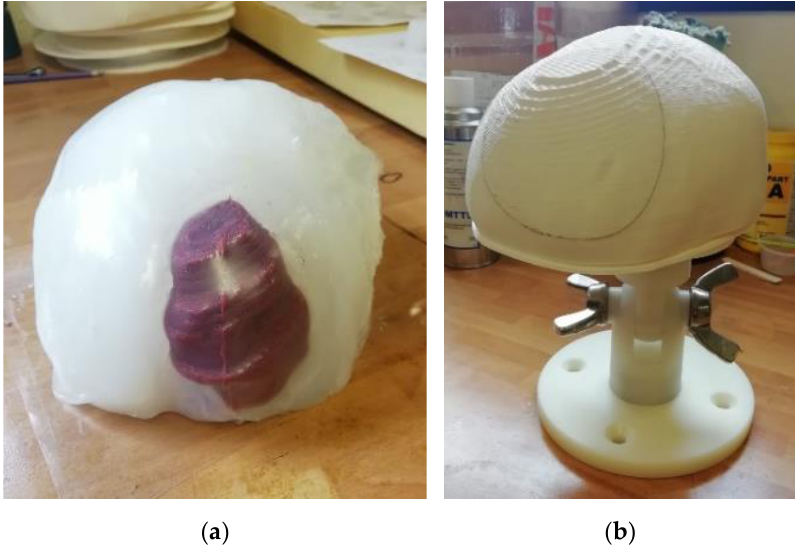
Figure 8. Final assembly: ( a ) brain with tumor and ( b ) complete model.